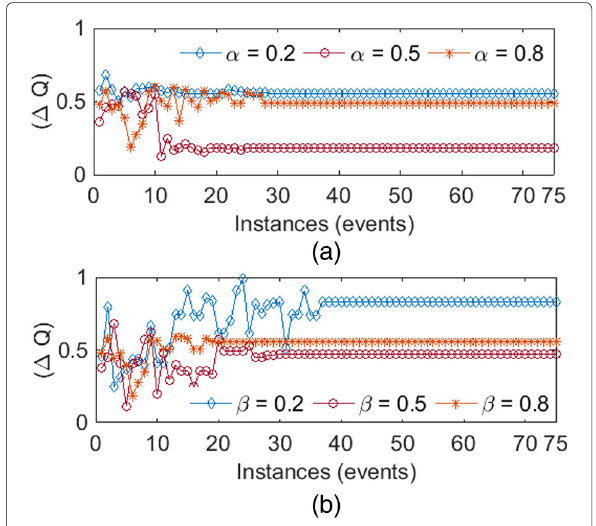
Fig. 6 Learning estimate ( (cid:3) Q ) convergence with varying a learning rate α ( ε = 0.5) and b discount factor β ( ε =